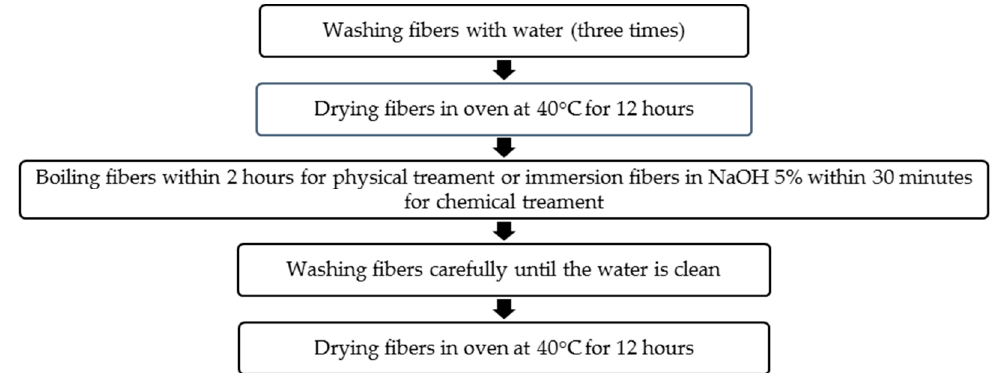
Figure 1. Process of fiber treatment applied.